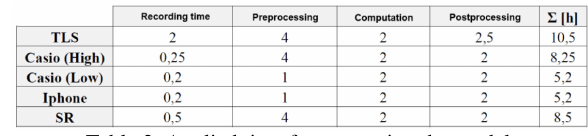
Table 2. Applied time for generating the